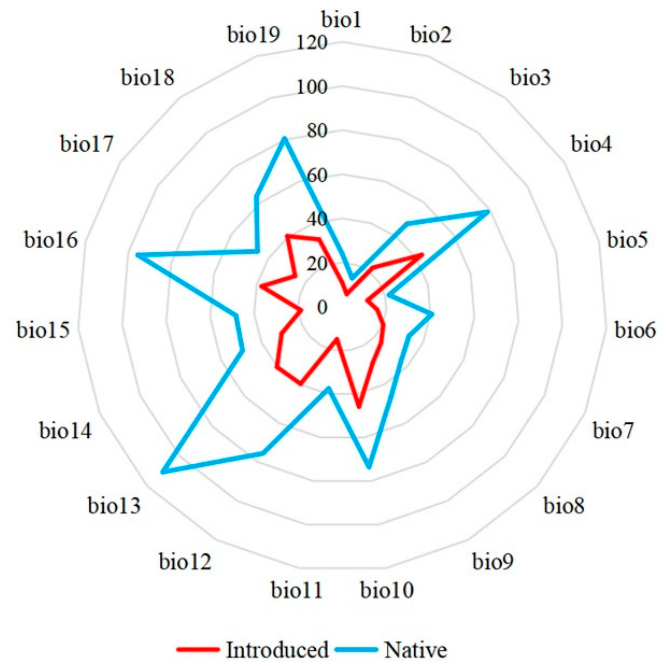
Figure 3. Comparisons of the ranges of the 19 predictors between those extracted from the occurrences of the fall webworm in Europe and the fall webworm in North America. Paired-samples t -tests showed that the ranges of the fall webworm in North America were significantly larger than those of the fall webworm in Europe ( p = 0.01). The abbreviations are as indicated in the Figure 2 legend.